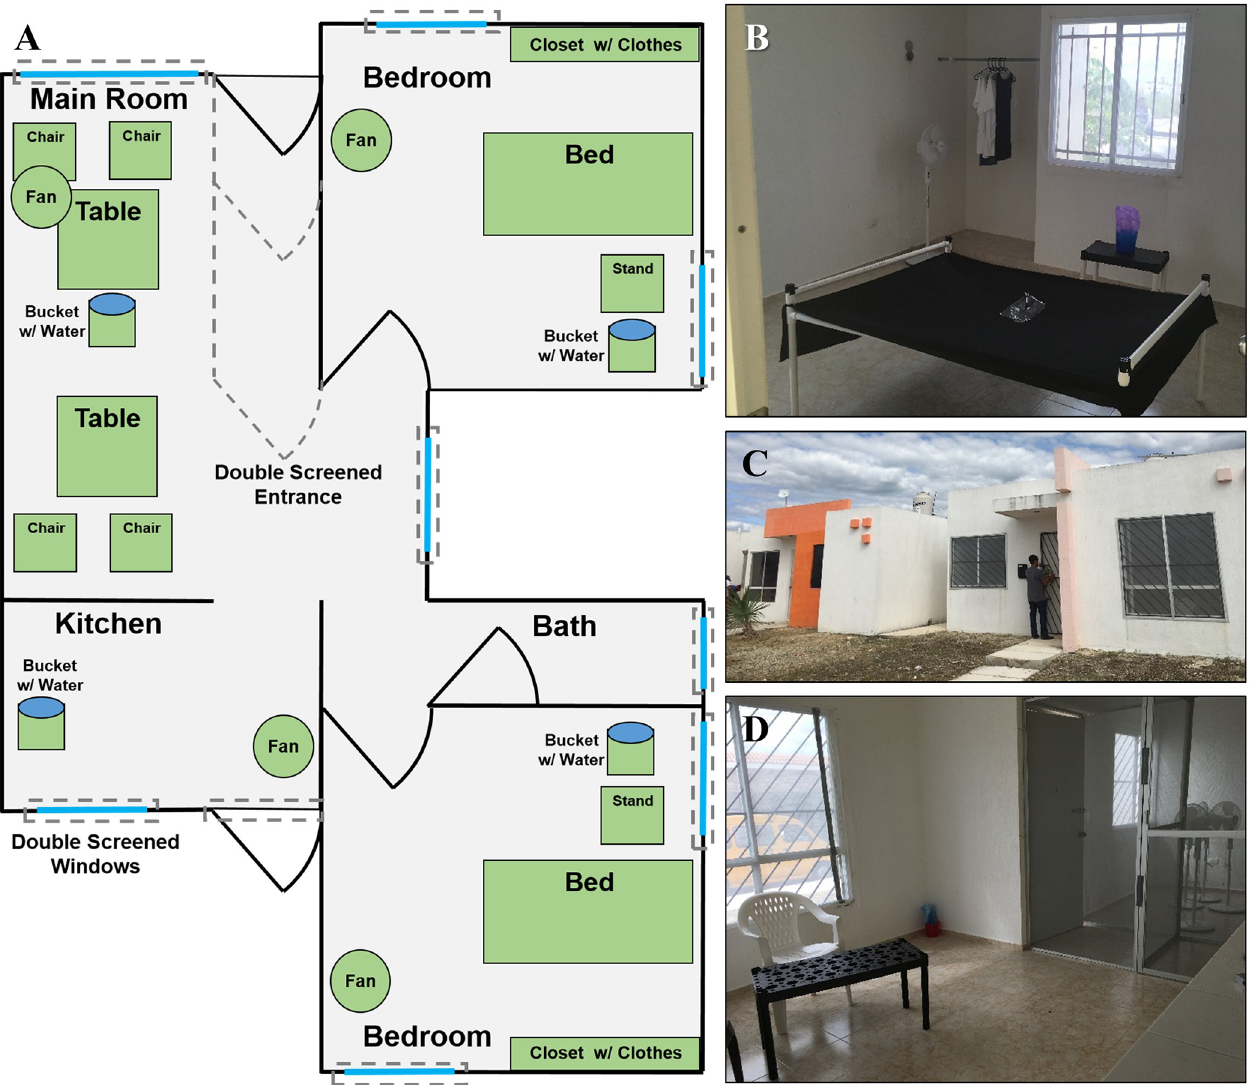
Fig 1. Layout of experimental houses. (A) General layout, (B) setup of bedrooms, (C) exterior entrance, and (D) living room and double-screened entrance of experimental houses.